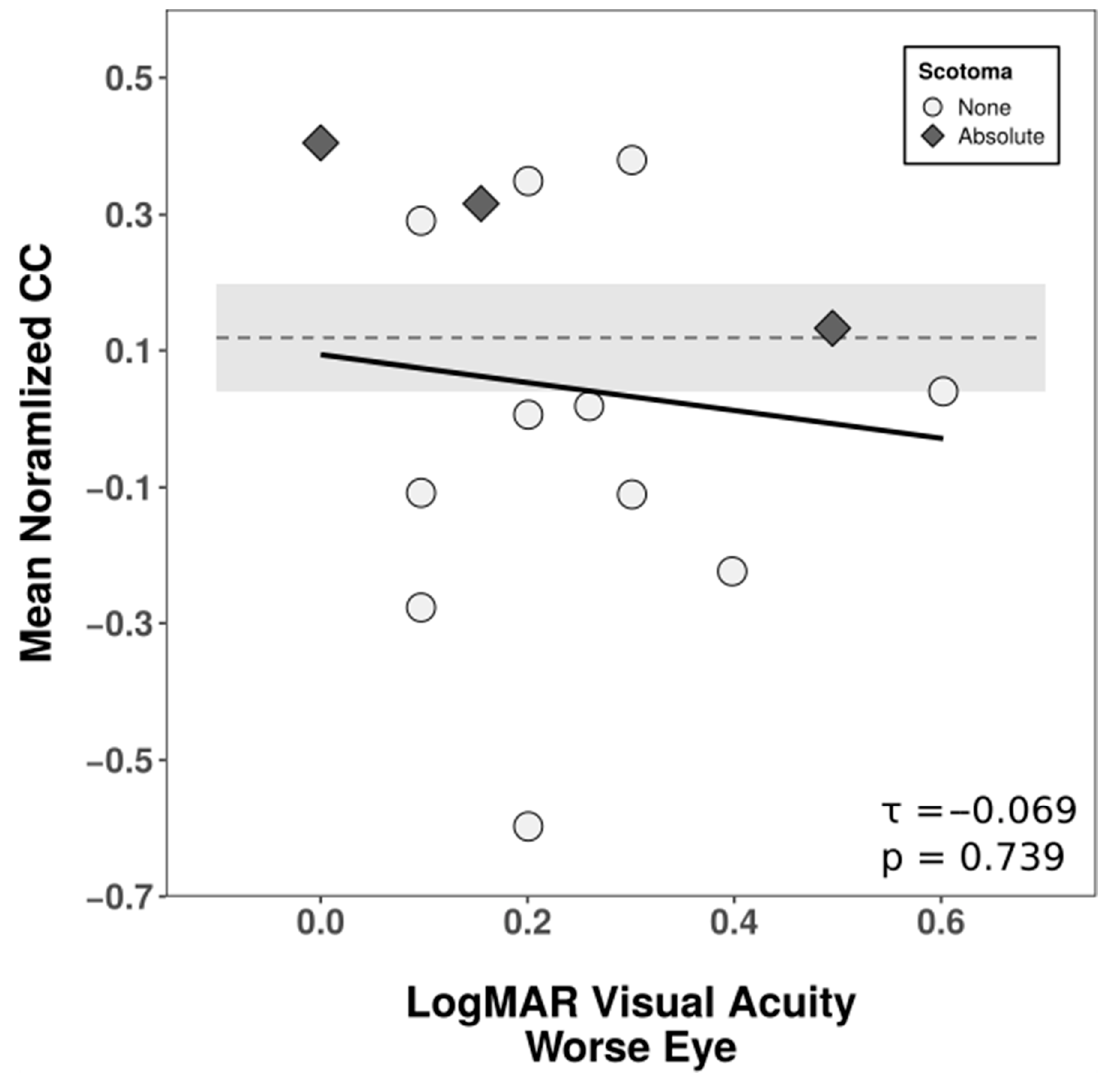
Figure 4. Relationship between the degree of foveal impairment in AMD patients (logMAR visual acuity worse eye) and normalized contextual cueing in response time in the last epoch in patients tested monocularly. Normalized contextual cueing was obtained by individually calculating the difference in mean response times between novel and repeated displays and standardizing this absolute difference by the mean response time of novel displays. Positive values indicate a benefit for repeated configurations. Rank correlations were quantified using Kendall’s τ . The solid line depicts the linear regression for the purpose of visualization. The dashed line represents the averaged mean normalized contextual cueing of controls, and the shaded area, the corresponding 95% confidence intervals.